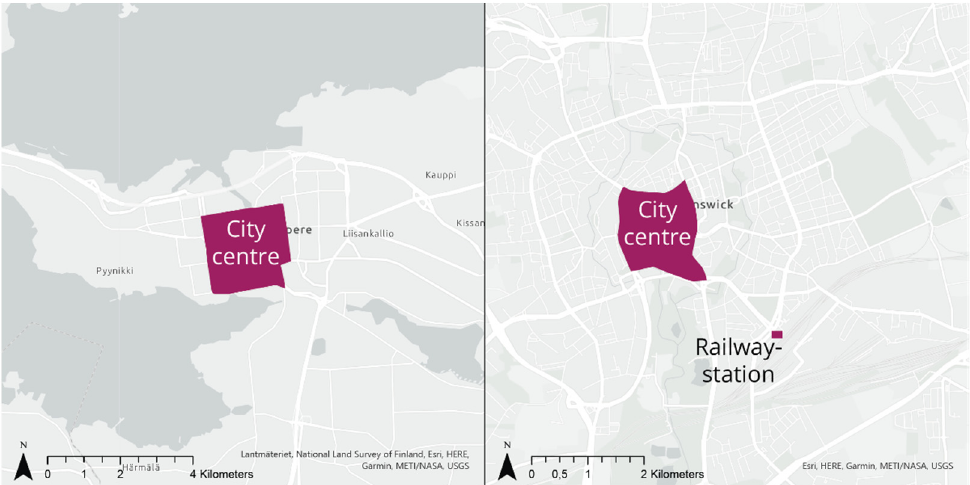
Figure 3. The city centre areas used in the spatial analysis, Tampere, Finland on the left and Braun- schweig, Germany on the right.